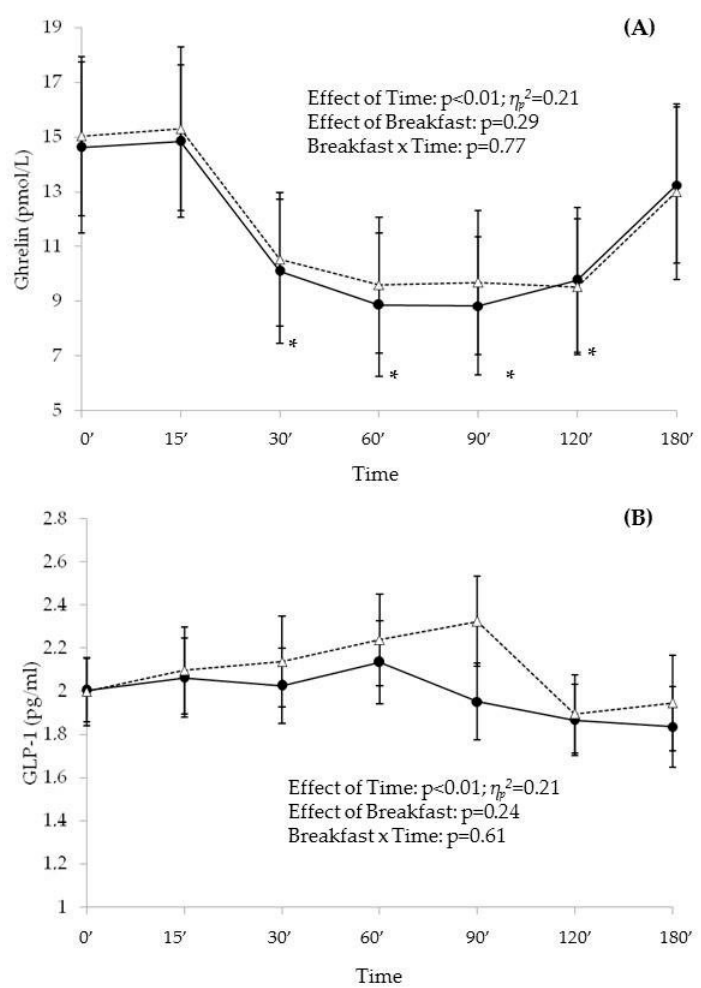
Figure 1. Appetite Ratings (Visual Analog Scale). Average and standard errors for VAS score (cm) after G-Breakfast ( ) and C-Breakfast ( ) at the different time points. The effects of time, breakfast and interactions were calculated by repeated measures ANOVA, except for CSI index that were calculated by repeated measures ANCOVA adjusted by Sex and BMI. # Statistically different means compared to baseline (0 ′ ) after G-Breakfast. † Statistically different compared to baseline (0 ′ ) after C-Breakfast.